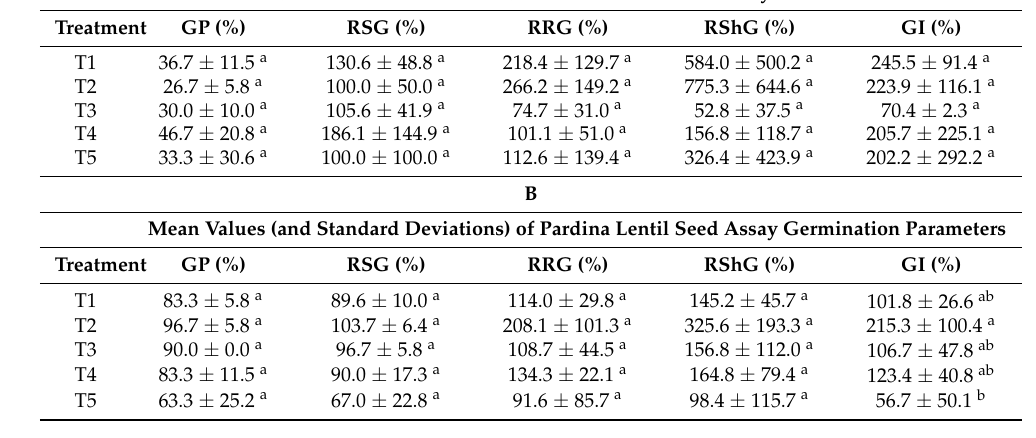
Table 2. The effect of the different combinations of the lavender with HM on germination parameters of bread wheat seeds (A) and Pardina lentil seeds (B) is evaluated. Specifically, the mean values and SDs of the germination percentage (GP), relative seed germination (RSG), relative root growth (RRG), relative shoot growth (RShG) and germination index (GI) are shown. Different letters indicate significant differences between treatments ( p < 0.05).